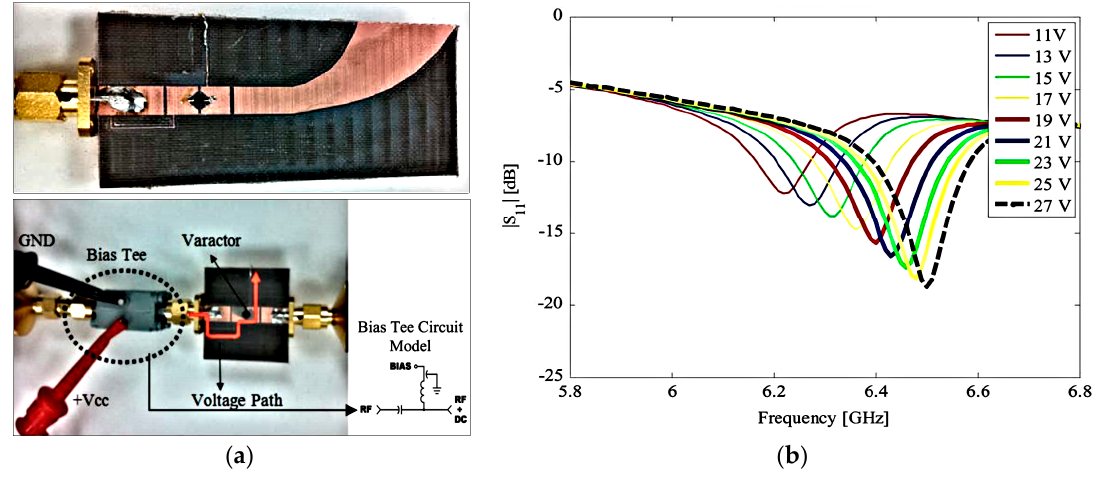
Figure 3. ( a ) Fabricated filtenna ( b ) its S 11 performance (redrawn from [35]).